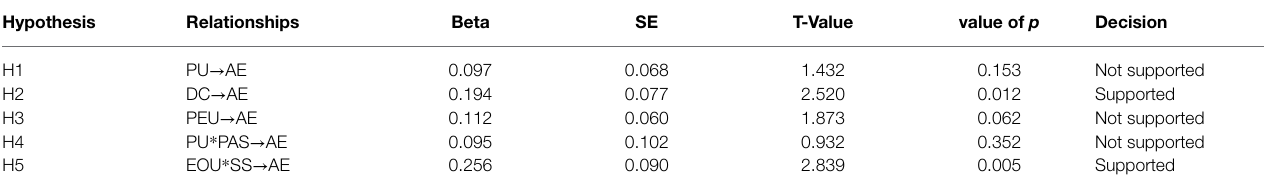
TABLE 5 | Structural model assessment with interactions.